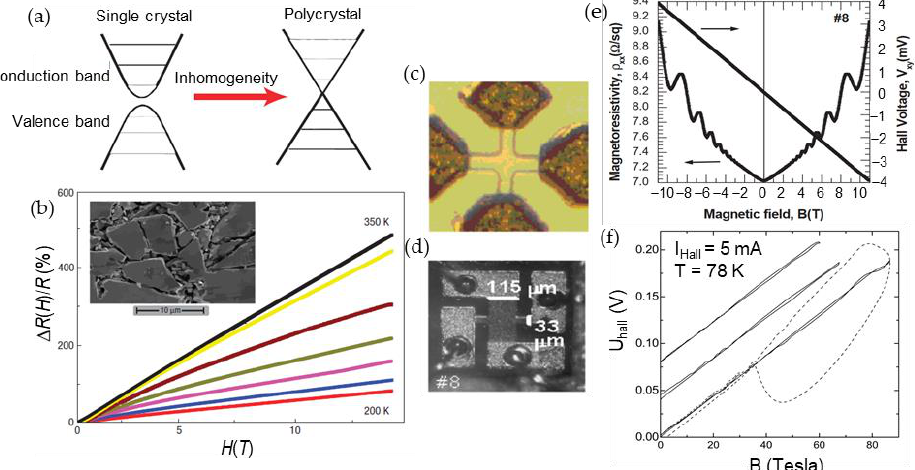
Figure 15. ( a , b ) Linear classical magnetoresistance in macroscopically inhomogeneous InSb: ( a ) in- homogeneities create tails in both the conduction and valence bands and cause them to overlap; ( b ) the linear magnetoresistance in the temperature range of (200 – 350) K. Inset: SEM image of an InSb polycrystal with typical grain size of 10 – 20 µm. Reprinted with permission from [111]. Copyright 2008 Springer; ( c ) picture of micro-Hall probe (MHP) based on Sn-doped n-InSb/i-GaAs MBE-grown heterostructures. The chip dimensions: 0.5 × 0.5 mm 2 with square sensitive area 20 × 20 µm; ( d ) the mesa of the MHP chip (0.6 × 0.6 mm 2 and sensitive area 115 × 33 µm). Reprinted with permission from [21]. Copyright 2010 Springer; ( e ) magnetoresistivity (left scale) and Hall voltage (right scale) for MHP measured at T = 1.1 K ( 𝐼 𝐴𝐶 13 𝐻𝑧 = 50 μA). The SdH oscillations in the Hall data are invisible due to the scale of this graph. Reprinted with permission from [112]. Copyright 2004 Elsevier; and ( f ) Hall signals measured in pulsed magnetic field. Solid lines: corrected Hall signal at three pulses (shifted). Dashed line: as-measured signal at the 87.2 T pulse. Reprinted with permission from [21]. Copyright 2010 Springer. As it was mentioned before, the geometric manipulation of the sample structures could increase the LMR [29,113]. Branford et al. [113] demonstrated this possibility in InSb epitaxial layers grown on GaAs substrate. They investigated magnetotransport properties of InSb structures fabricated in Corbino, EMR and disk geometries and observed the in- creasing linearity of the magnetoresistance with increasing number of disc arrays, what is predicted by classical PL model. It was found that the EMR geometry produces the highest MR values at low field, while the Corbino geometry allows to achieve the largest non- saturating linear magnetoresistance values at high fields. Another configuration — microminiature Hall sensors — was proposed by Mironov et al. [21,112] for pulsed magnetic field measurements up to megagauss (see Figure 15c,d. Figure 15e presents magnetoresistance and Hall voltage dependences on magnetic field up to 11 T for microminiature Hall sensors based on Sn-doped n-InSb/i-GaAs MBE-grown